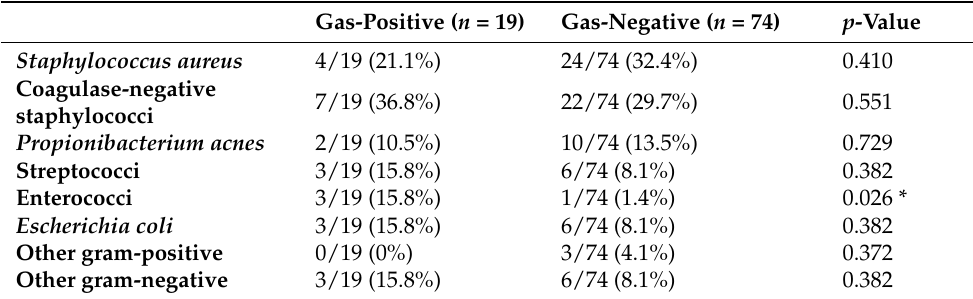
Table 3. Pathogen spectra found in gas-positive and gas-negative patient groups. * indicates statisti- cally significant